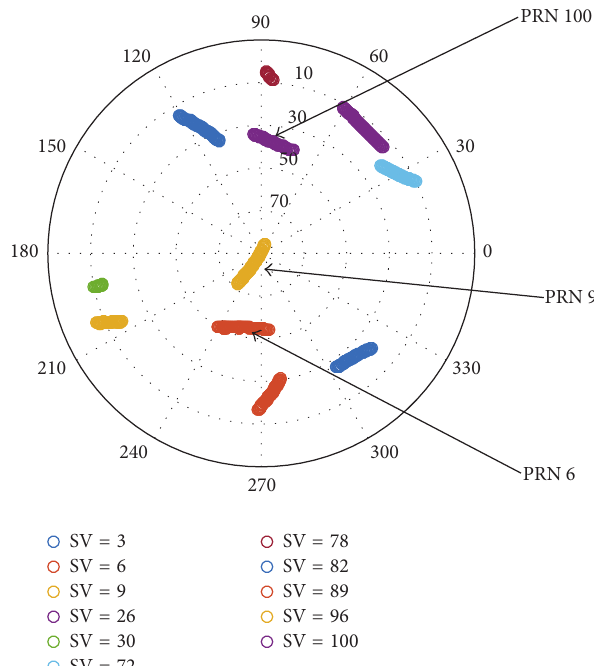
Figure 6: Skyplot of the combined GPS (SVs 1–32)/Galileo (SVs 71–100)constellationprovidingL1/E1andL5/E5asignalsasobserved during the flight